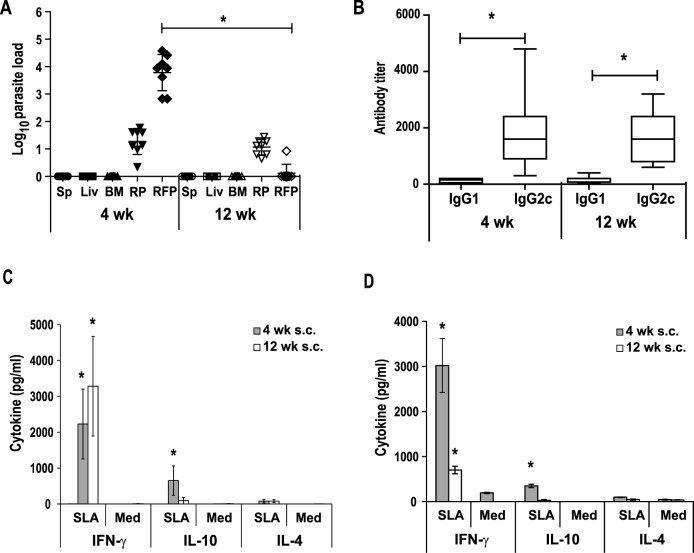
C57BL/6 mice chronically infected with the LiΔHSP70-II showed a Th1 like response against Leishmania.C57BL/6 mice (n = 8) were infected with 1 × 107
LiΔHSP70-II promastigotes in the right footpad (s.c.). LiΔHSP70-II parasite burdens were analyzed at week 4 or at week 12 after vaccination by limiting dilution in the spleen (Sp, parasites per total organ), liver (Liv; parasites per g), bone marrow (BM; parasites per 1 × 107 cells), in the right popliteal lymph node (RP; parasites per total lymph node) or right footpad (RFP; parasites per total footpad) (A). Scatter plots are shown including the mean ± standard deviation (SD). No statistical differences were found in the parasite burdens in the RP from week 4 to week 12 whereas a significant decrease was shown in the RFP (unpaired Student t-test). At week 4 or at week 12 after vaccination, animals were euthanized and spleen cell cultures and sera were prepared. The IgG1 and IgG2c reciprocal end-point titer against L. infantum SLA was determined by ELISA and represented as whisker (min to max) plots (B). * (P < 0.05) indicates the statistical differences between IgG1 and IgG2c anti-SLA titers within each group (Mann-Whitney test). For cytokine determinations spleen cells (C) or RP cells (D) were cultured in the absence (Med) or in the presence L. infantum SLA. Levels of IFN-γ, IL-10 and IL-4 were assessed by ELISA in culture supernatants. Mean ± standard deviations (SD) are shown in C and mean ± standard error of mean (SEM) are shown in D. * (P < 0.01) shows the statistical differences between SLA-stimulated and non-stimulated cells (unpaired Student t-test). No parasite loads or SLA-dependent cytokines were detected in saline immunized mice. Results are representative of two independent experiments.